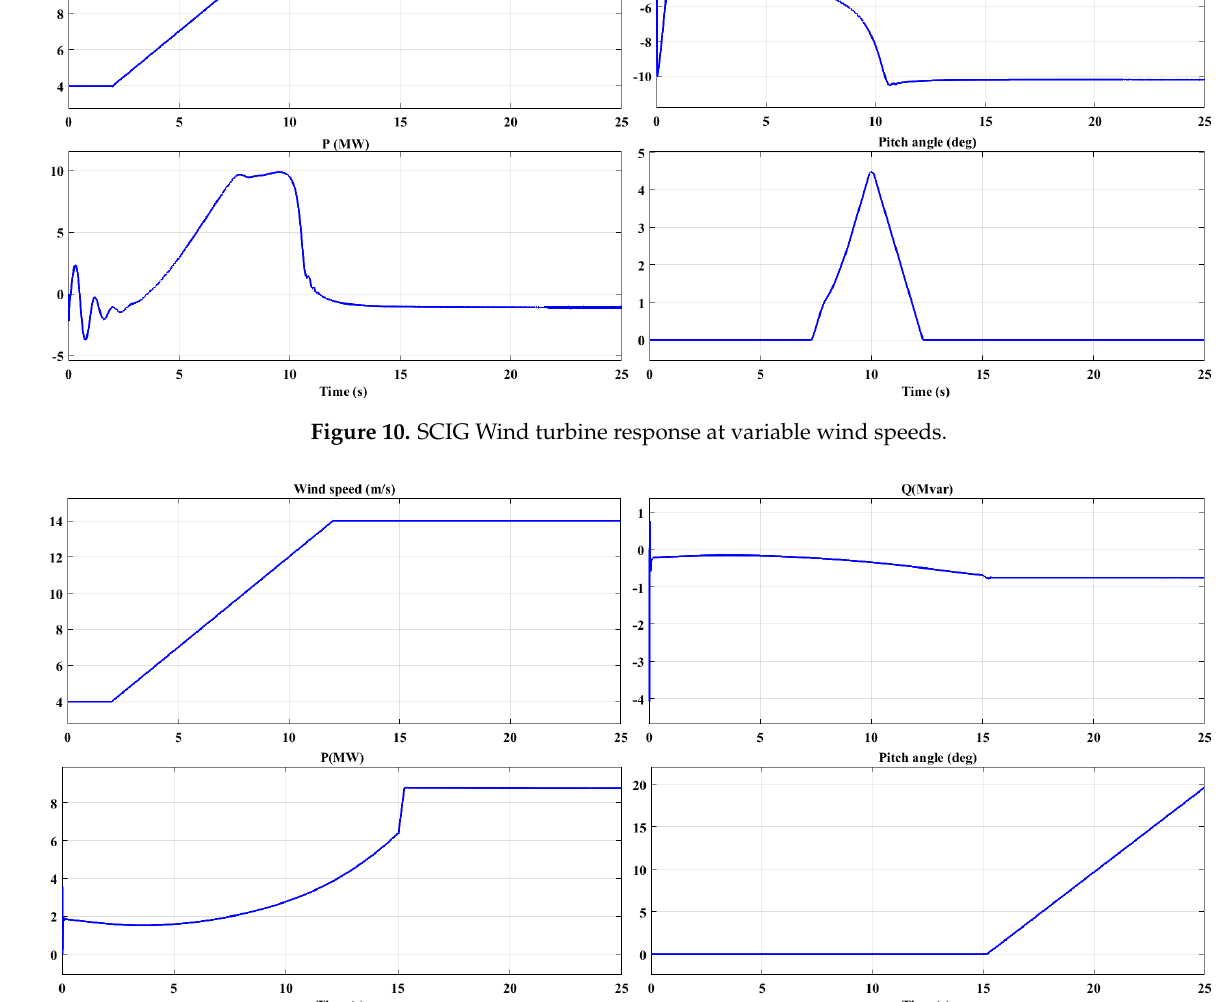
Figure 12. SCIG gird parameters at steady-state operation condition.